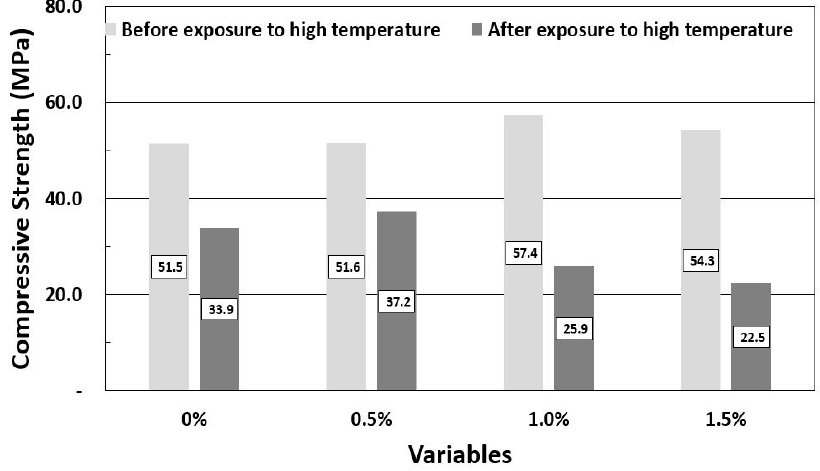
Figure 6. Compressive strength before and after high temperature exposure with polymer content (%).